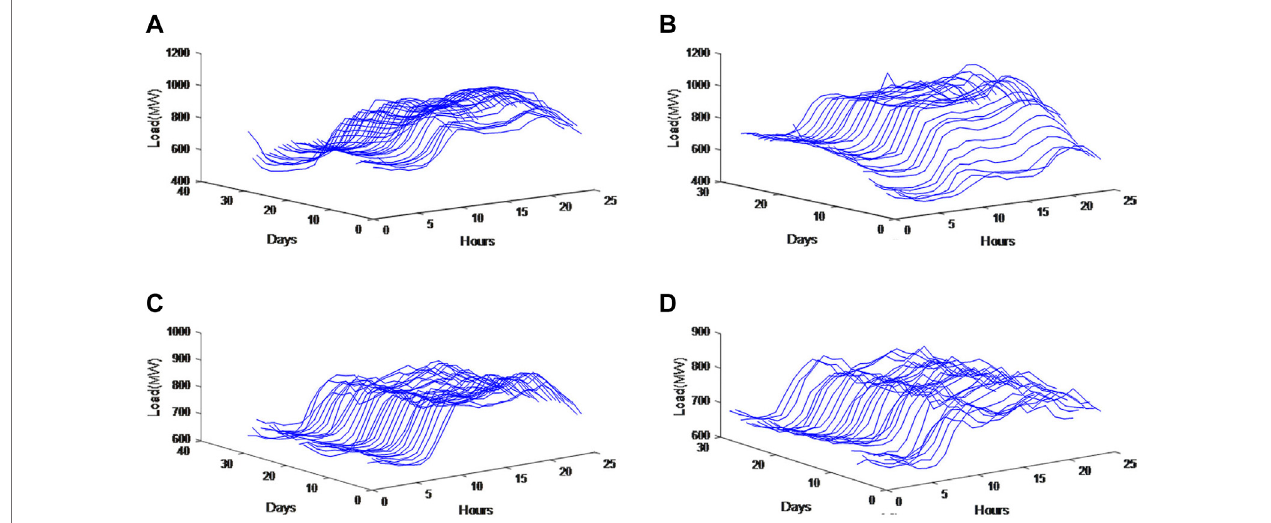
FIGURE 3 | Historical power load curve: (A) January 2014, (B) February 2014, (C) March 2014, and (D) April 2014.